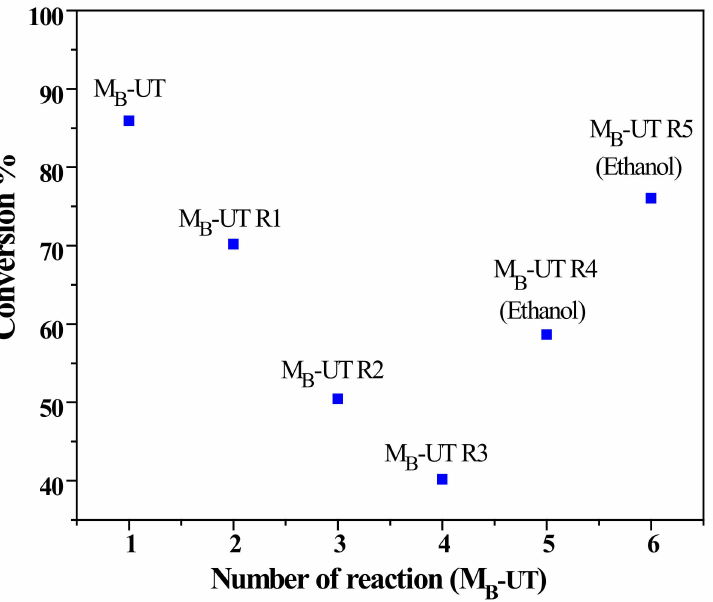
Figure 6. Catalitic activity of the M B -UT reused with methanol (M B -UT R1, M B -UT R2, M B -UT R3) and ethanol (M B -UT R4, M B -UT